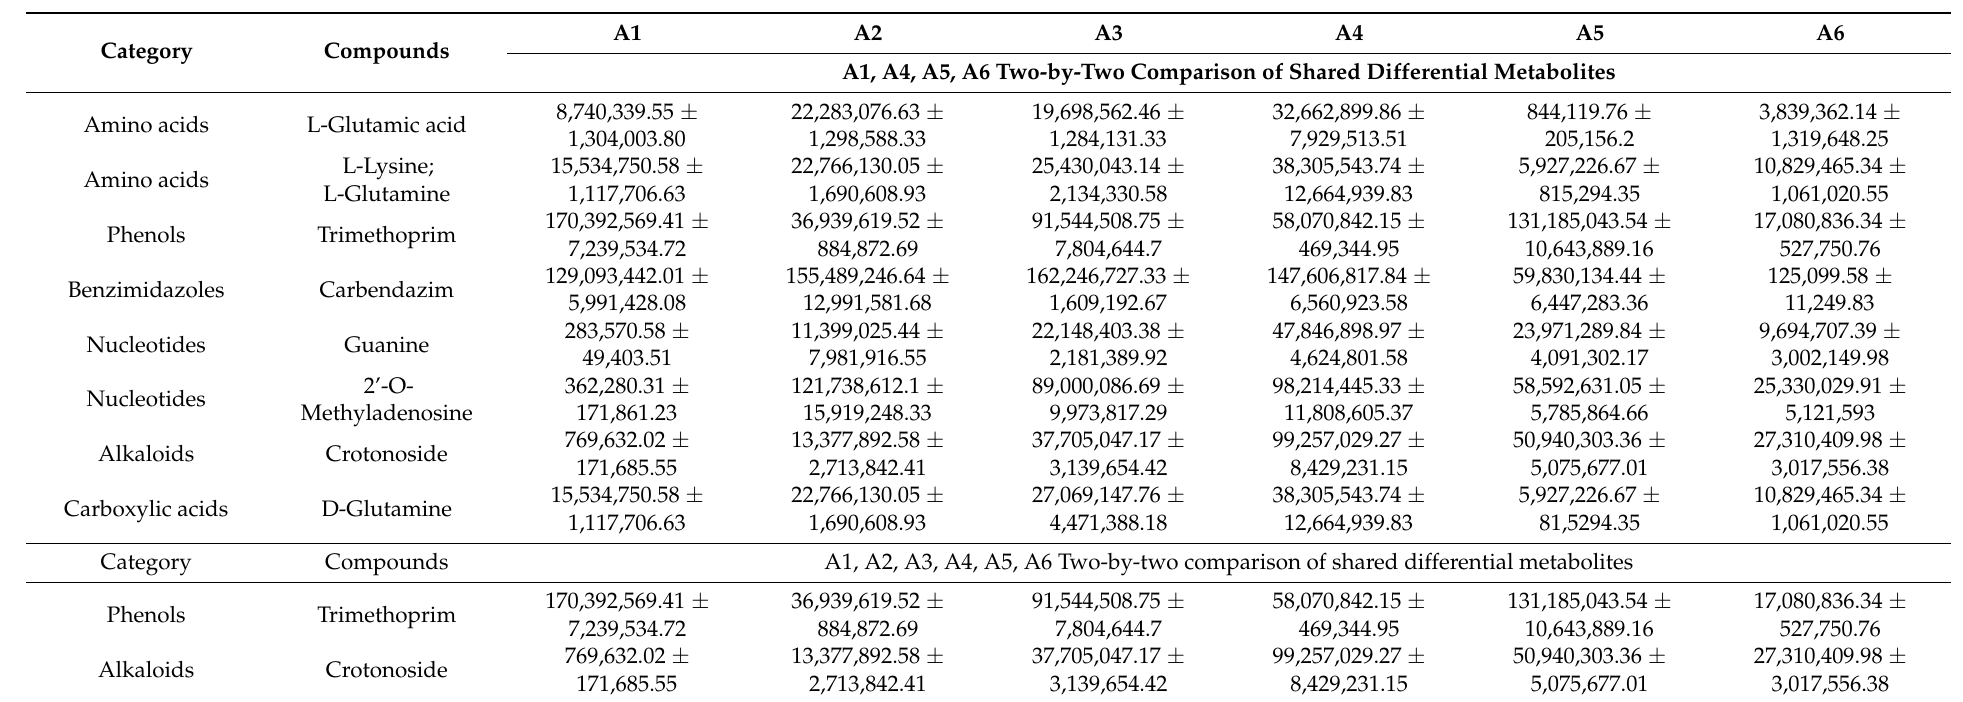
Table 5. Identification of differentially expressed metabolites from a two-by-two comparison of six